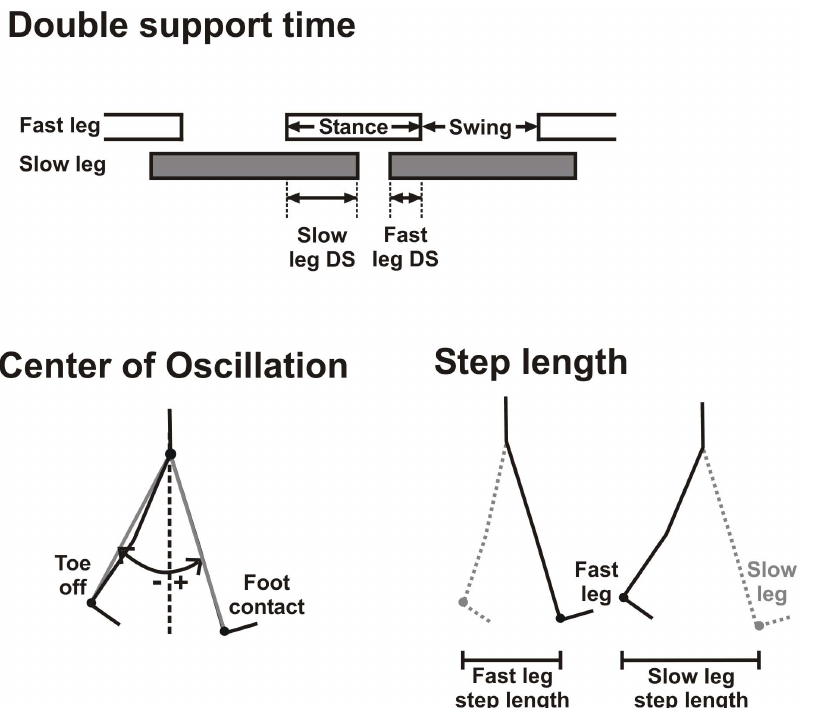
Figure 2. Parameters to determine symmetry of walking. Each walking cycle has two periods of double support (DS), as shown by the overlap between the stance phase of the fast leg (open bars) and the slow leg (filled bars). Slow DS or fast DS is when the slow or the fast leg is trailing, respectively. Symmetry in DS is the difference between the two DS periods, divided by the sum of the two. Centre of oscillation is measured from the limb angles, which is the angle formed with the vertical (dashed line) by the line joining the greater trochanter and lateral malleolus (grey lines). Centre of oscillation for each limb is the midpoint of the limb angle from the start of stance (max limb angle, , foot contact) to the end of stance (min limb angle, , toe off). Symmetry in center of oscillation is the difference between centers of oscillation for the fast and slow legs. Step length is the distance between the ankle marker of the leading and trailing limb at the time of foot contact of the leading limb. Symmetry in step length is the difference between the fast and slow step length divided by the sum of the two.